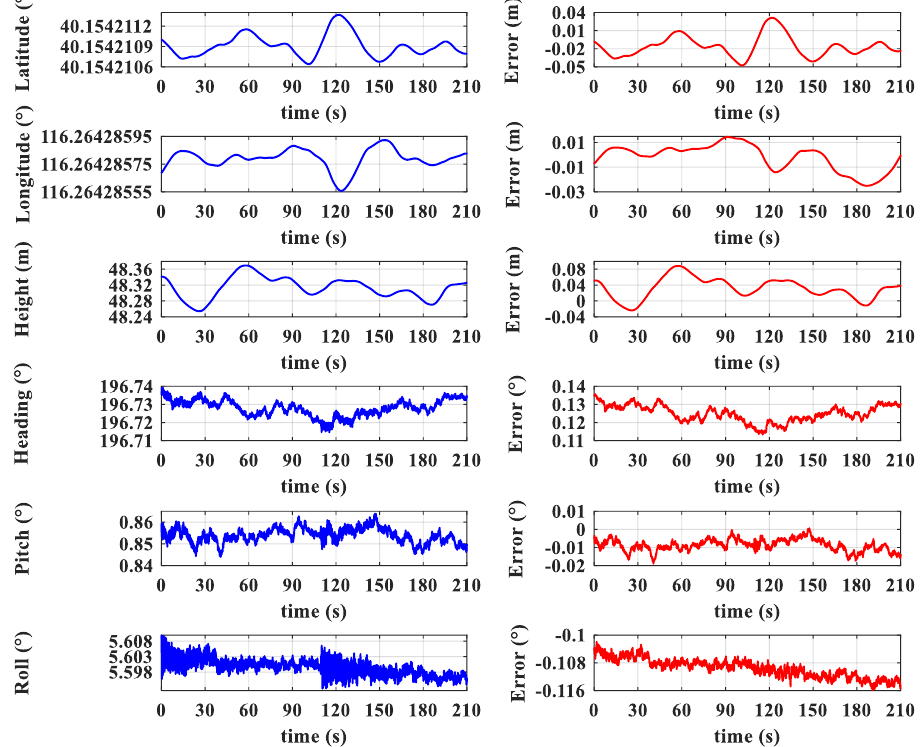
Figure 16. Measured values and errors of position and attitude for antenna 6.